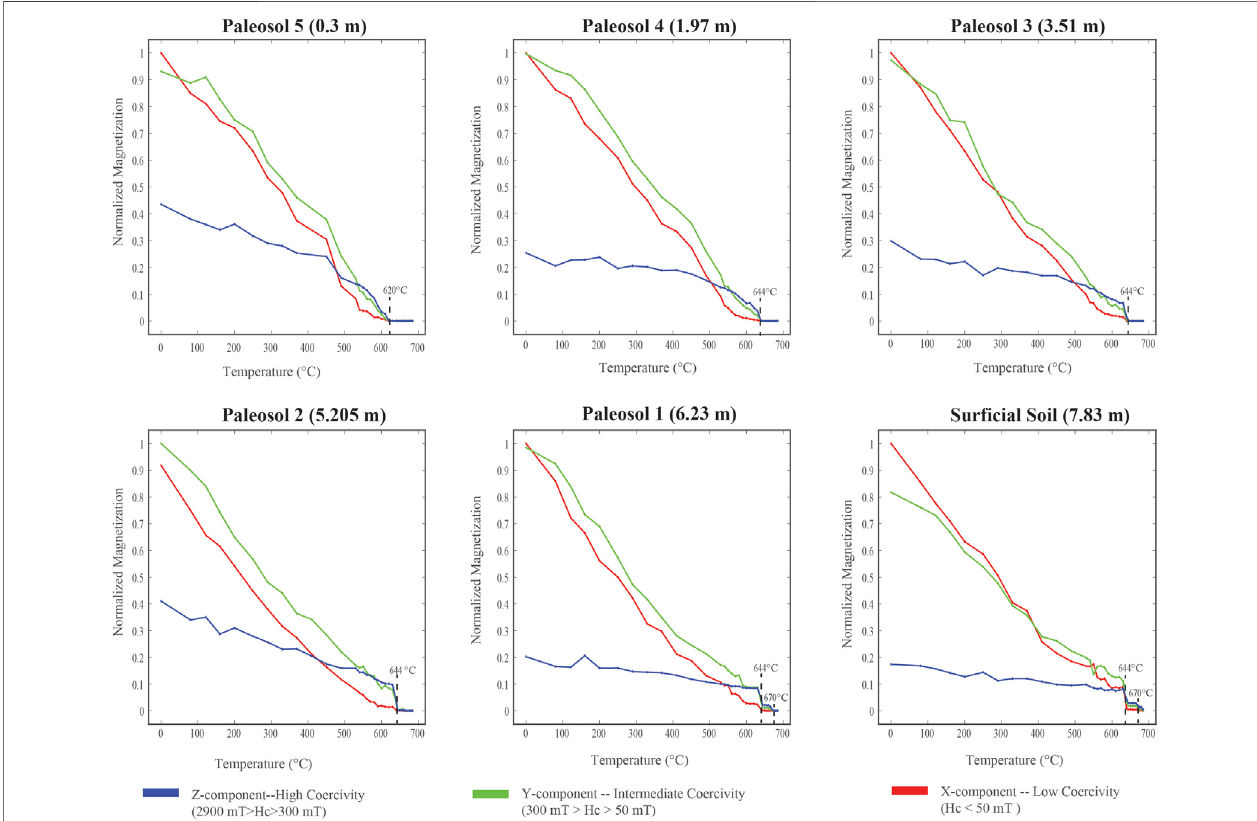
FIGURE 10 | Three component IRM progressive thermal demagnetization (Lowrie, 1990) of six representative specimens from each of the fi ve palesols in addition to the Sur fi cial Soil of the BDF. The z-direction (blue line) represent the hard-coercivity (IRM 2.9T ) component, the y-direction (green line) represent the intermediate- coercivity component (IRM 300mT ), and the x-direction (red line) represent the low-coercivity component (IRM 50mT ).